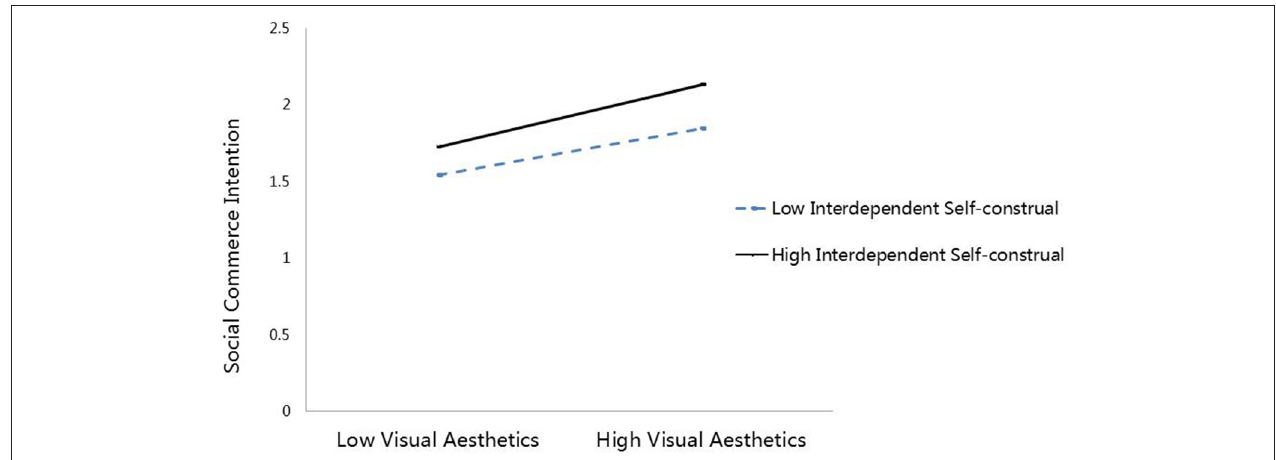
FIGURE 2 | The moderating effect of interdependent self-construal between visual aesthetics and social commerce